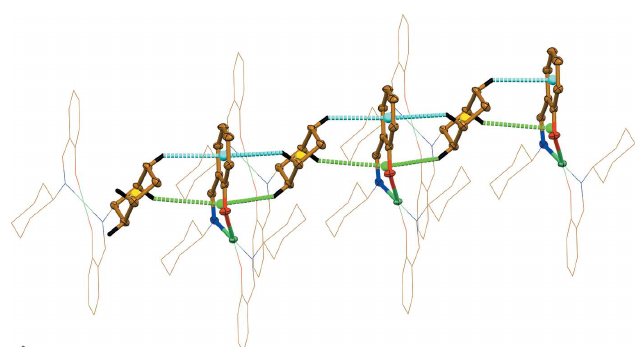
Figure 3 A view on the intermolecular interactions formed by the benzene, cyclohexyl and chelate rings in the crystal structures of [Ni( L I ) 2 ] and [Cu( L I ) 2 ] (50% atomic displacement ellipsoids are shown for the non- hydrogen atoms of the interacted fragments). Hydrogen atoms not involved in the interactions are omitted for clarity. Colour code: H = black, C = gold, N = blue, O = red, M = green, a C—H (cid:2)(cid:2)(cid:2) (cid:2) (benzene) interaction = cyan dashed line, a C—H (cid:2)(cid:2)(cid:2) (cid:2) (chelate) interaction = green dashed line, a centroid of the benzene ring = cyan ball, a centroid of the chelate ring = green ball, a centroid of the cyclohexyl ring = yellow belonging to the family of C—H (cid:2) (cid:2) (cid:2) (cid:2) contacts, is electro- statically dominated with the major attractive (cid:2) E = Coulomb (cid:4) 6.41 kcal mol (cid:4) 1 , whereas, interestingly, in the latter case, the Coulomb term appears to be repulsive and the sole prevailing attractive constituent is the exchange-correlation energy (cid:2) E = (cid:4) 7.23 kcal mol (cid:4) 1 (Fig. 4, Table 4). Notably, the XC second longer O (cid:2) (cid:2) (cid:2) H contact leads to the overall complex